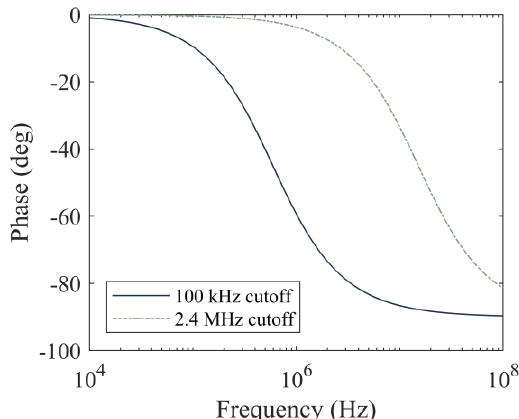
Figure 6. Phase lag as a function of frequency, induced by low pass filters with cutoffs at 100 kHz and 2.4 MHz.